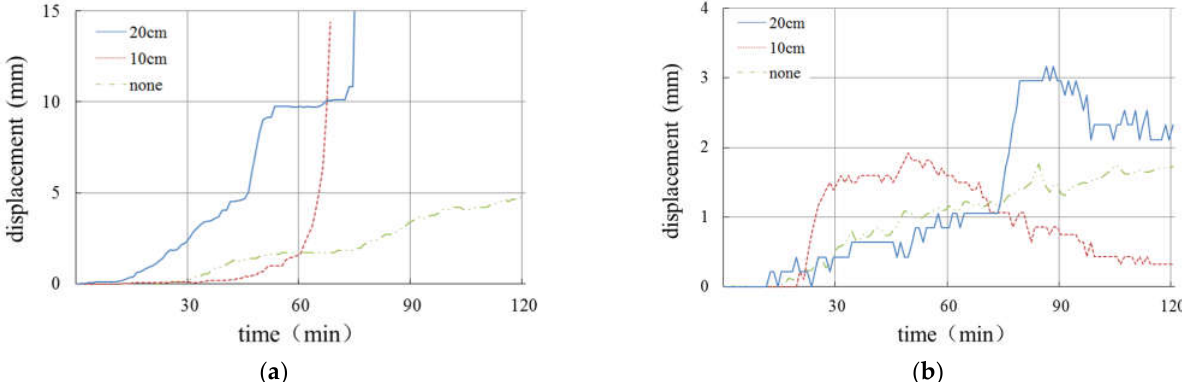
Figure 23. Curves of displacement and pore pressure under rainfall intensity of 60 mm/h. ( a ) Curves of displacement. ( b ) Curves of pore pressure.